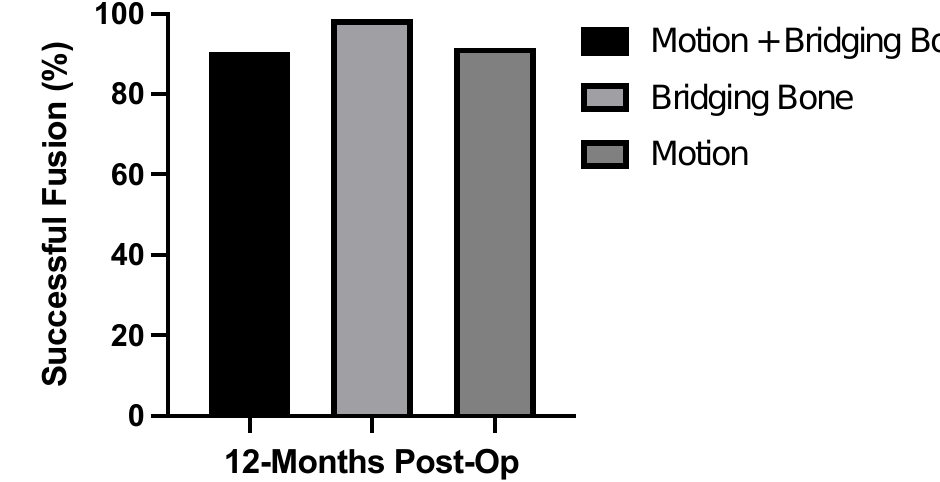
Figure 1. Spinal fusion success rate. A high rate of fusion success was observed in lack of motion + bridging bone, bridging bone only, and lack of motion only.